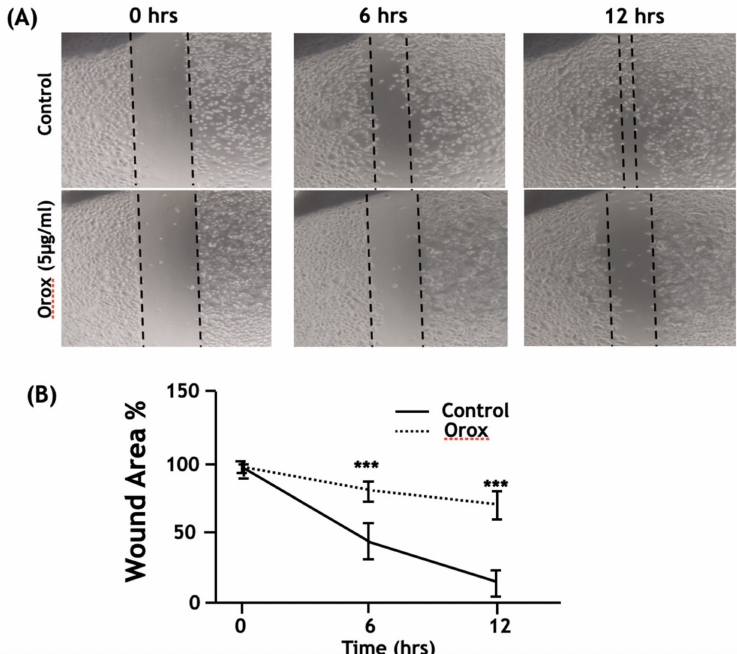
Figure 8. Oroxyquinone inhibits PC3 cell migration. The PC3 cells were cultured, and a wound healing assay was conducted as described in the Materials and Methods by treatment with 5 µ g/mL of oroxyquinone (Orox) or PBS (Control). ( A ) The pictures represent the images of the same cells of each group recorded at 0, 6, and 12 h of treatment. The dark marks on the upper left side of the image were to make sure the images were recorded on the same field each time. ( B ) In order to measure the area of the wound, the length of the scratches was measured on the light microscope and plotted on a graph. The wound area of the control at 0 hr was taken as 100%, and means and SD were calculated. p -values were calculated comparing with the control values of the same h of treatment by students’ “ t ” test. *** indicates p -value >